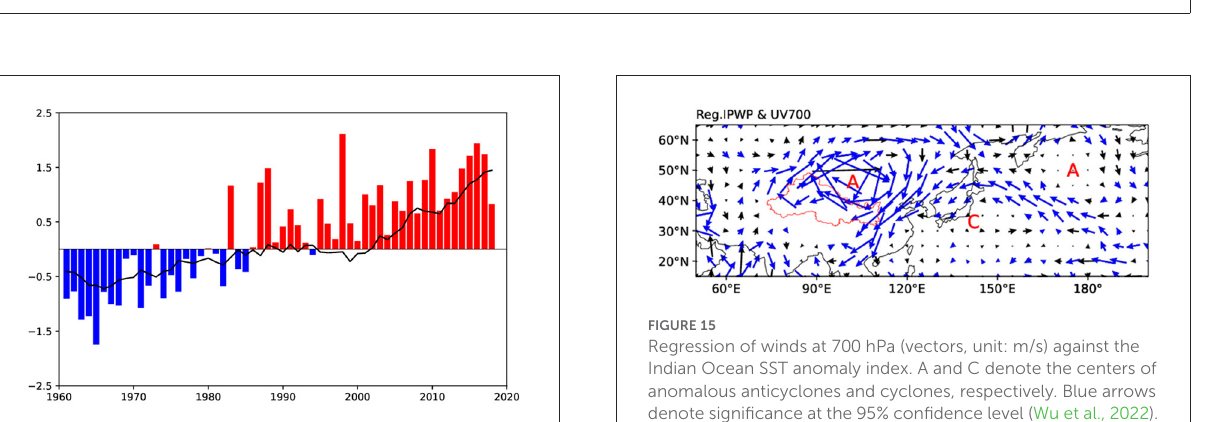
FIGURE14 Time series of Indian Ocean SST anomaly indices (the black line is the normalized summer precipitation index).